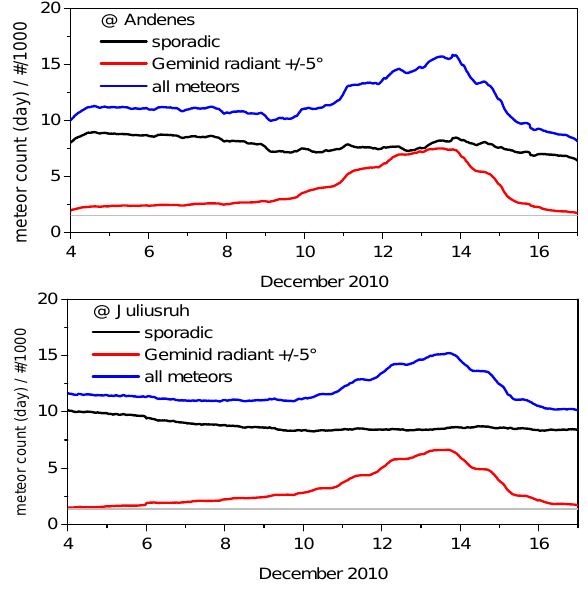
Fig. 7. Daily meteor count rate separated for sporadic activity and potential Geminids using source radiant for the Andenes and Julius- ruh. The x-tickmarks indicate 00:00UTC for each